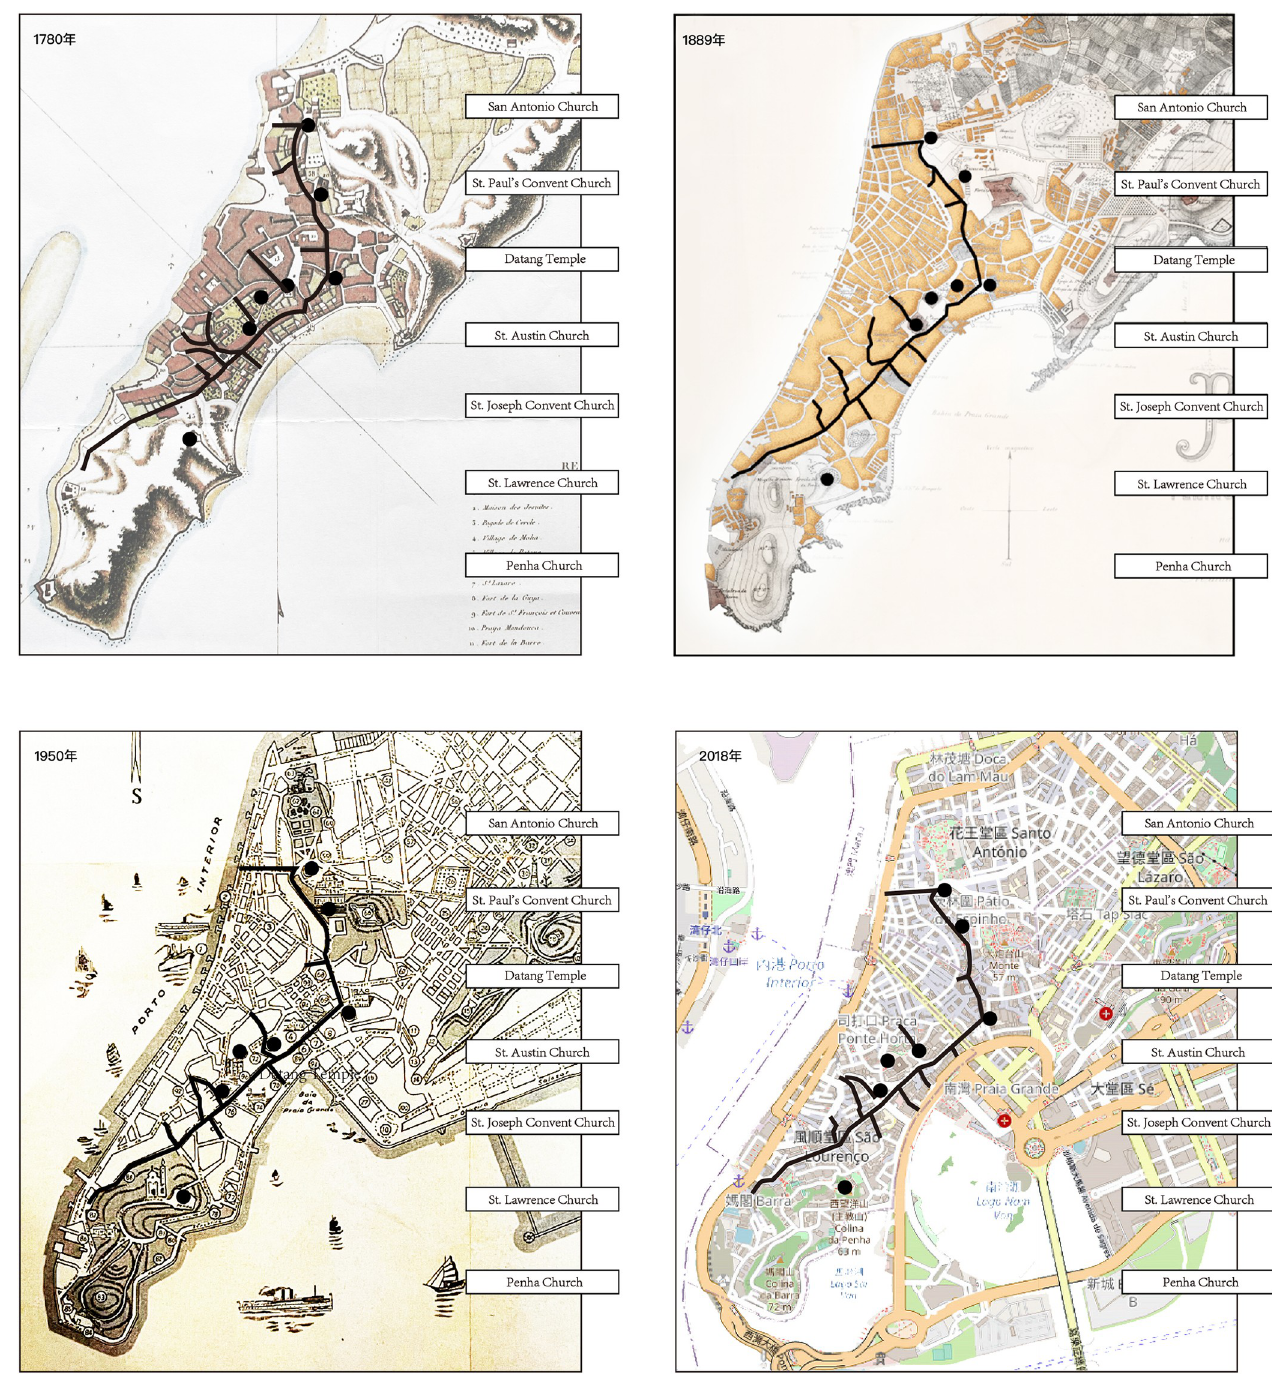
Fig 8. Historical layering of straight streets in Macau [45]. (1780, 1889, 1950, and 2018). Reprinted from [MNL.05.03. CART 1780] under a CC BY license with permission from [ARQUIVO DE MACAU], original copyright [1780]. Reprinted from [MNL.10.18h. CART 1889] under a CC BY license with permission from [ARQUIVO DE MACAU], original copyright [1889]. Reprinted from [MNL.05.26. CART 1950] under a CC BY license with permission from [ARQUIVO DE MACAU], original copyright [1950]. Reprinted from [https://viewer.nationalmap.gov/advanced-viewer/] under a CC BY license with permission from [USGS National Map Viewer], original copyright [2018]. Image source: The author selected the historical maps of 1780, 1889, 1950, and 2018 as the base maps for layering analysis and self-drawing. The base maps of 1780, 1889, and 1950 were obtained from the Archives of Macau, Cultural Affairs Bureau, Macau S.A.R. Government. The base map of 2018 was obtained from the USGS National Map Viewer. https://viewer.nationalmap.gov/advanced- viewer/.